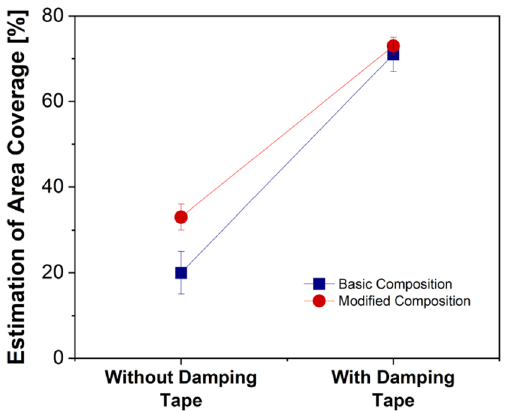
Figure 5. Comparison of the estimation of secondary plateau area coverage without and with damping tape for the BC and MC specimens.